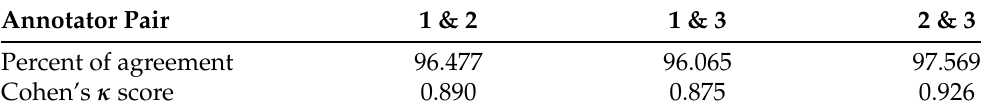
Table 5. Agreement scores by each pair of annotators of the binary classification of negation. Annotator Pair 1 & 2 Percent of agreement 96.477 Cohen’s κ